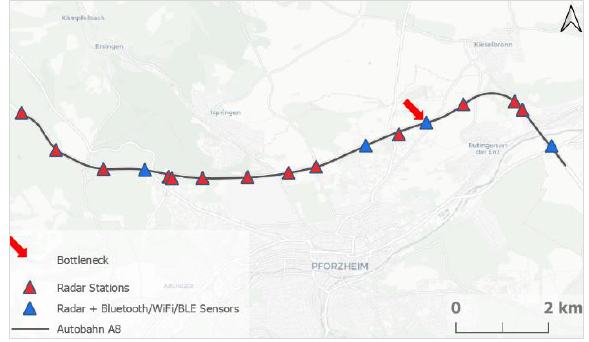
Figure 1: The planned installation of radar stations and Bluetooth/WiFi/BLE sensors on the A8 section. The bottleneck shows the point where the road narrows from three to two